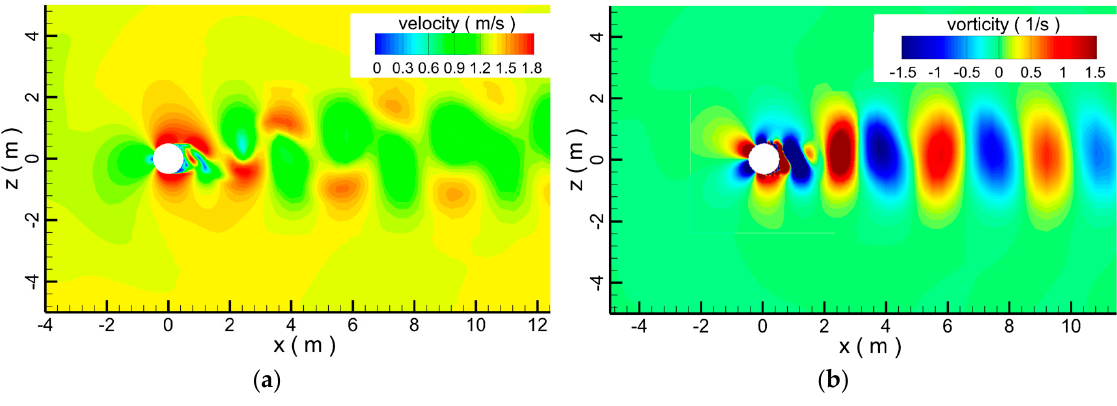
Figure 6. Flow field. ( a ) Velocity. ( b ) Vorticity.